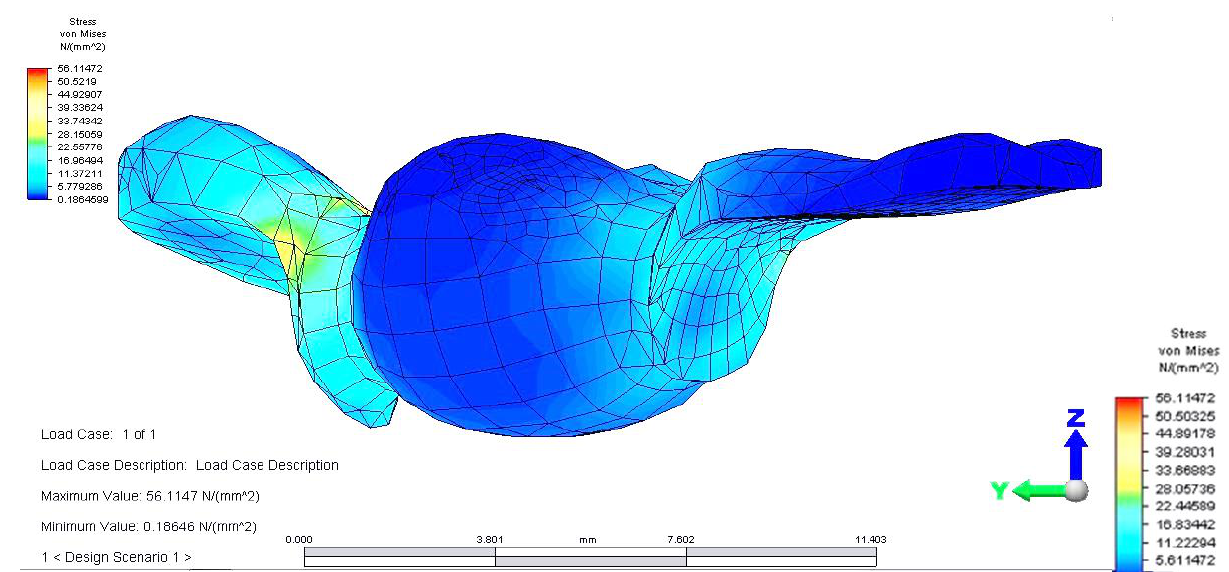
Figure 10. Tension distribution at the bridge level in three directions: axonometric, right and left, when the force is placed in the 3.4 area.